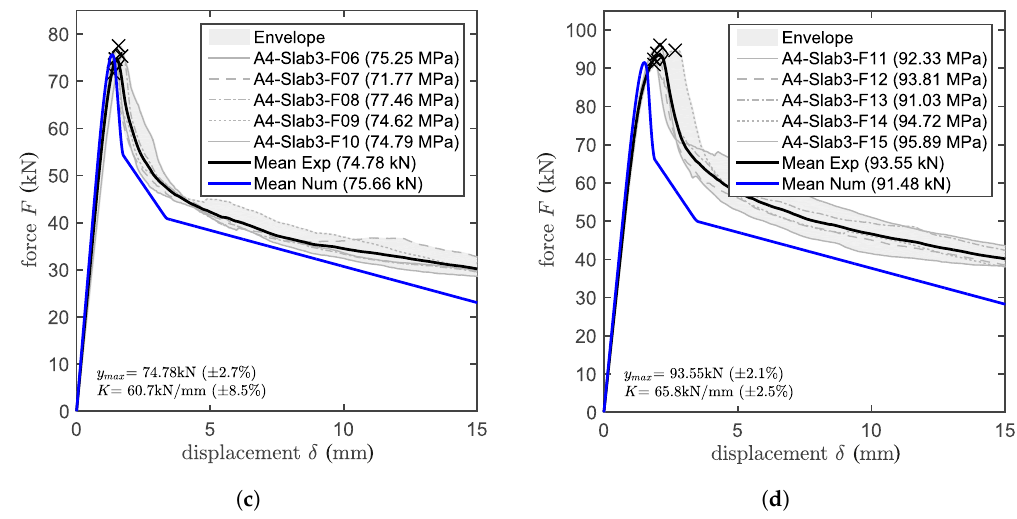
Figure 8. ( a ) Set-up of confined pull-out tests partially un-bonded. Experimental and numerical results for different bonded lengths: ( b ) 70 mm, ( c ) 90 mm, ( d ) 110